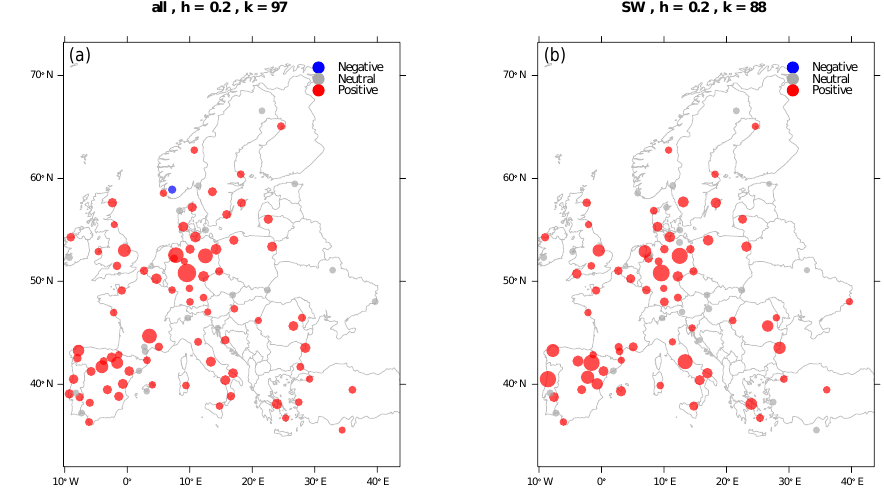
Figure 3. Location of the cluster centres and the weights assigned to them by the linear regression (size scale) for (cid:37) C = 0 . 8 ( ˆ= τ = 0 . 2) and training over all time steps (a) and over the time steps with prevailing CWT SW (b) .